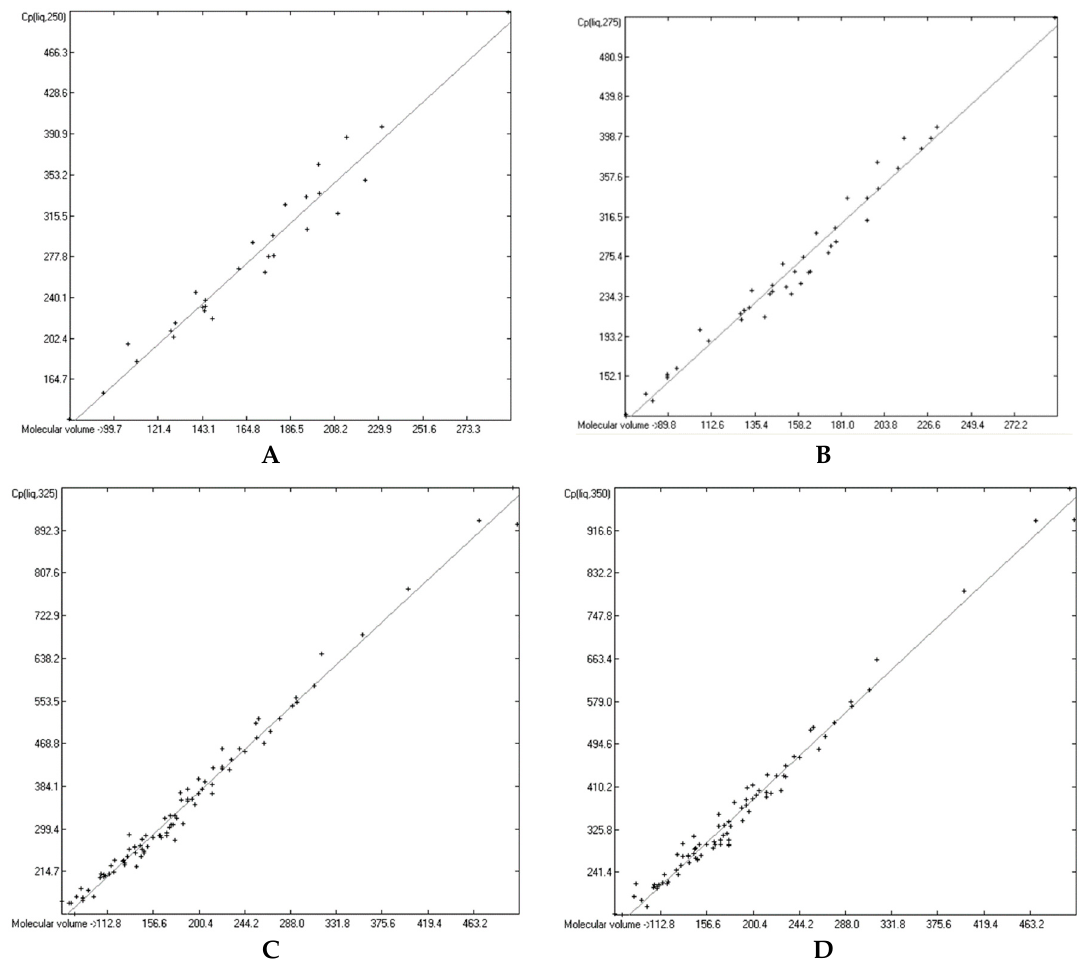
Figure 15. Correlation of molecular volumes with liquid heat capacities of OH-free compounds at various temperatures. ( A ): 250 K. ( B ): 275 K. ( C ): 325 K. ( D ): 350 K. Table 15. Statistics of liquid heat capacities of OH-free compounds at various temperatures.